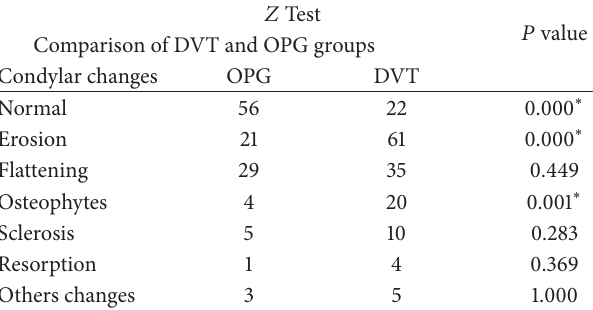
Table 6: Comparison of DVT and OPG